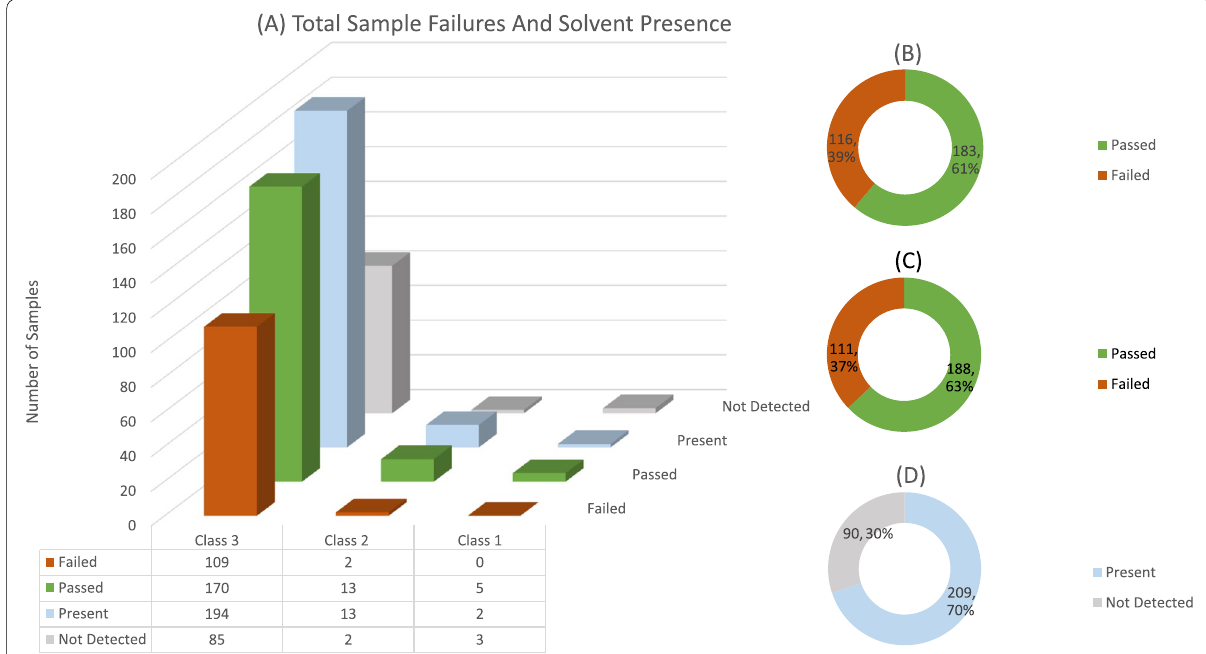
Fig. 1 Number of sample failures, and the number of samples that contained solvent ( A ). Total percentage of sample failures for all classes, if all solvents present in a sample are summed ( B ). Total number of sample failures for all classes where one solvent exceeded the limit ( C ). Total percentage of samples for all classes where any solvent was detected in sample ( D